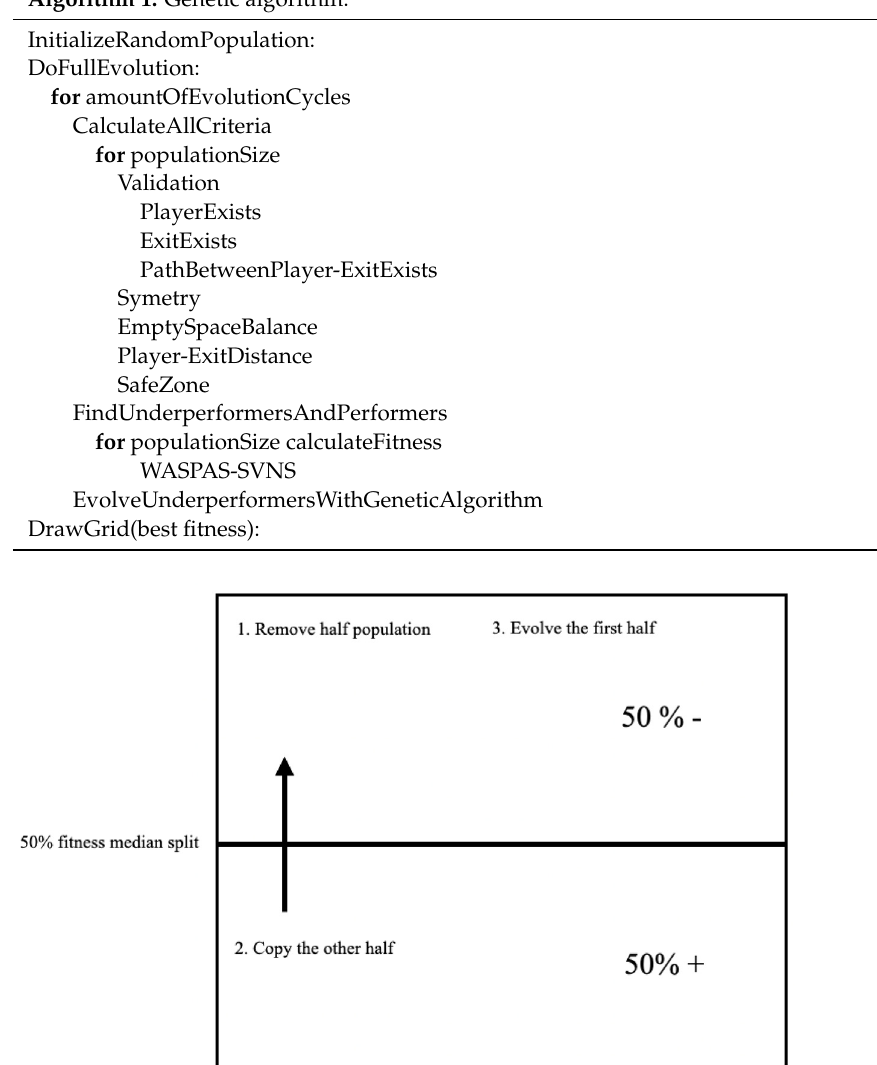
Algorithm 1. Genetic algorithm.